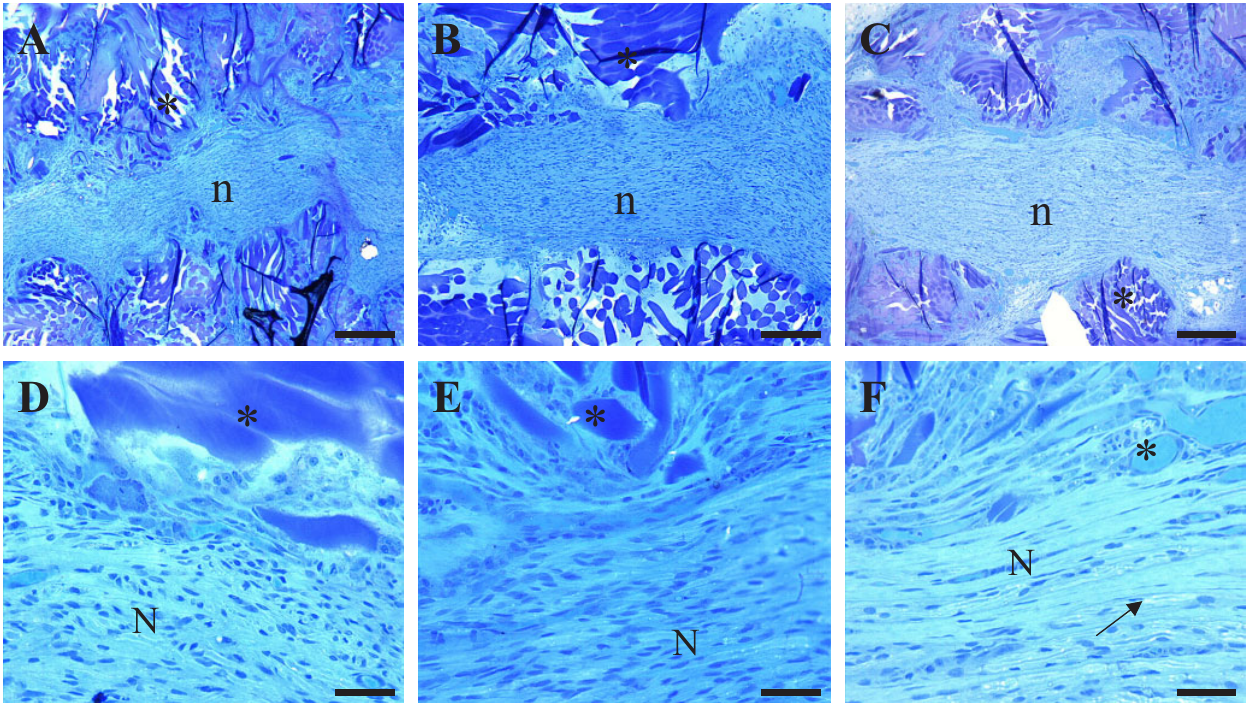
Figure 4 Light micrographs of transversal sections of the nerve guide explanted sections that were toluidine blue stained. (A), (B) and (C) represent week 7, 15 and 21, respectively. (D), (E) and (F) represent enlargements of biomaterial/nerve tissue interfaces for week 7, 15 and 21, respectively. N = nerve tissue; asterisks point at biomaterial; arrow in (F) points at myelinated nerve tissue. Scale bars in (A), (B) and (C) represent 2 mm; scale bars in (D), (E) and (F) represent 100 µ m. Table 1 Hind paw automutilation in rats implanted with a Hyaff11 nerve guide Weeks after Number of rats ( n ) No automutilation Moderate Severe implantation automutilation automutilation